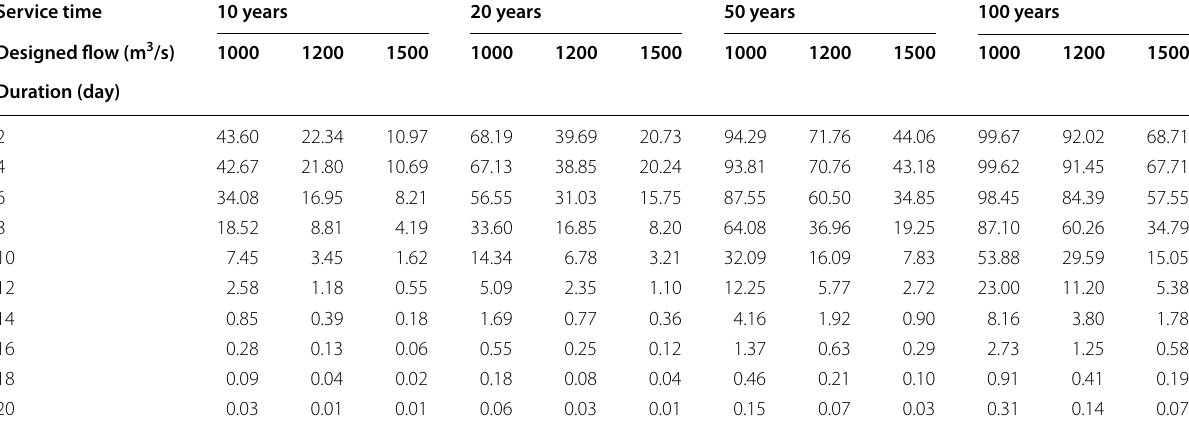
Table 8 The flooding risk in Xiangxi river under different peak-duration scenarios (%) Service